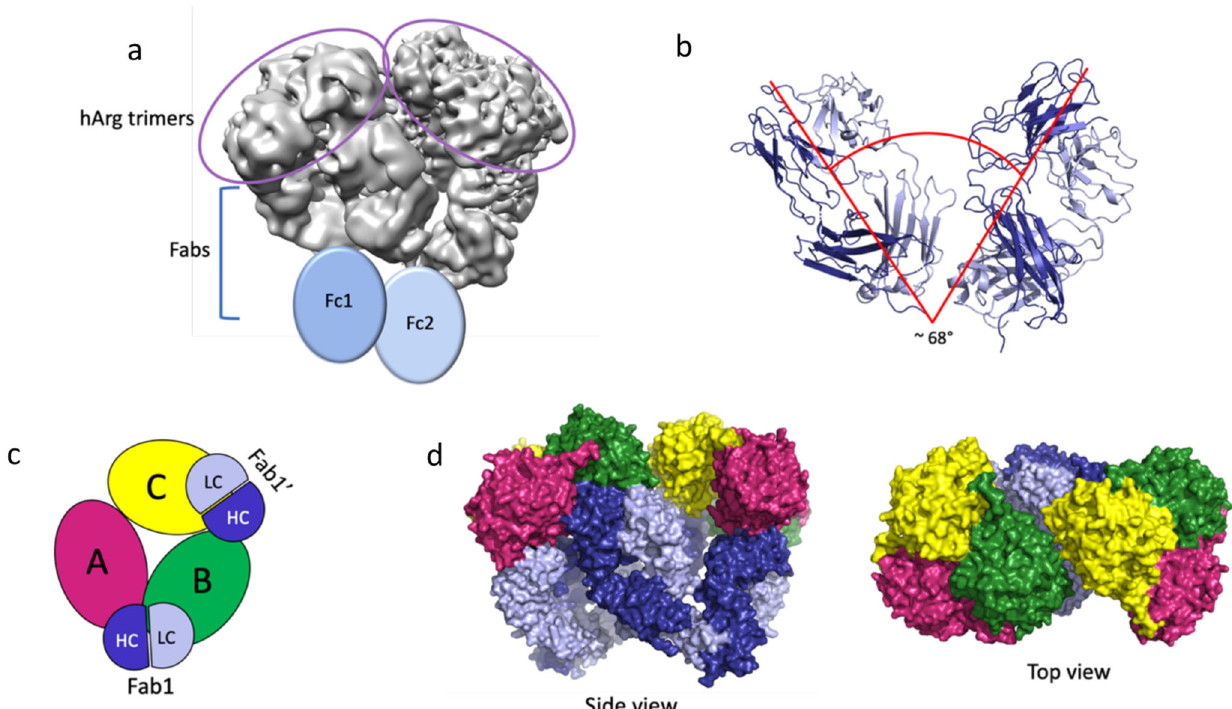
Fig. 3 The mAb1 2:2 complex. a The resulting EM maps allow for the identi fi cation of the two trimers and two sets of Fabs. As with the 2:3 complex, the Fcs were not visible but are added here to show their general location in this complex. b The angle between the two FABS is ~67 o which is signi fi cantly smaller than the ~160 o angle seen in the 2:3 complex. c An overview of how the 2:2 complex assembles with hArg1 monomers and the mAbs colored as in Fig. 2 is shown as a simplistic cartoon representation. Here it is apparent that that arrangement of the antibodies is quite asymmetric and only one monomer (monomer B here) makes all three mAb interactions (mAb1 LC and HC; and mAb2 HC) as seen in the 2:3 complex. d Two surface representations show both a side view and a top view of this 2:2